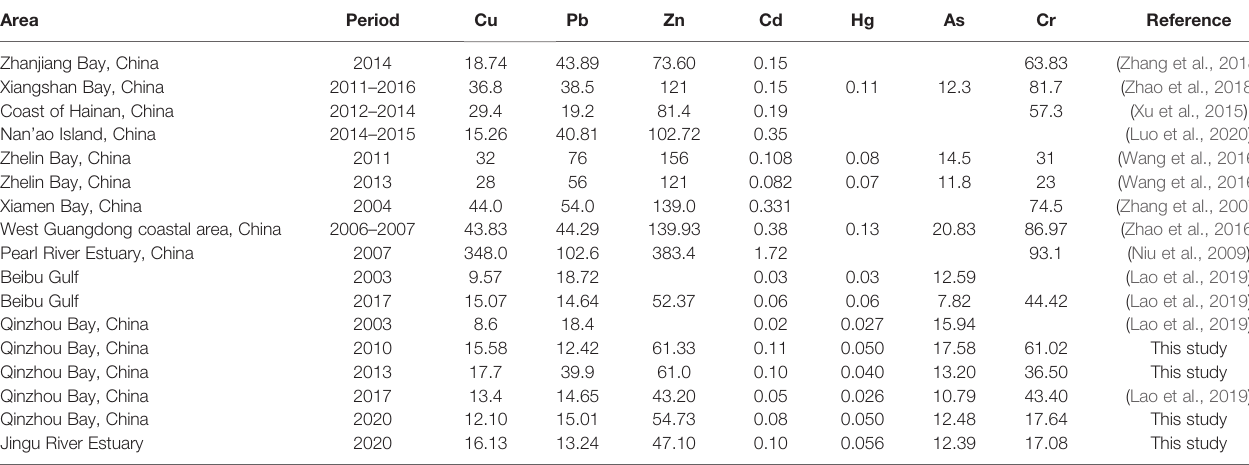
TABLE 4 | Comparison of heavy metal concentrations ( m g g -1 ) in surface sediments with those in other regions. Area